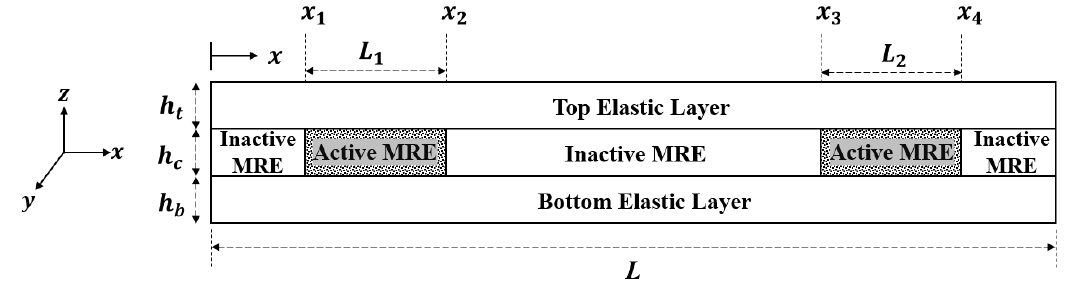
Figure 7. Schematic of the sandwich beam structure with MRE-core layer.